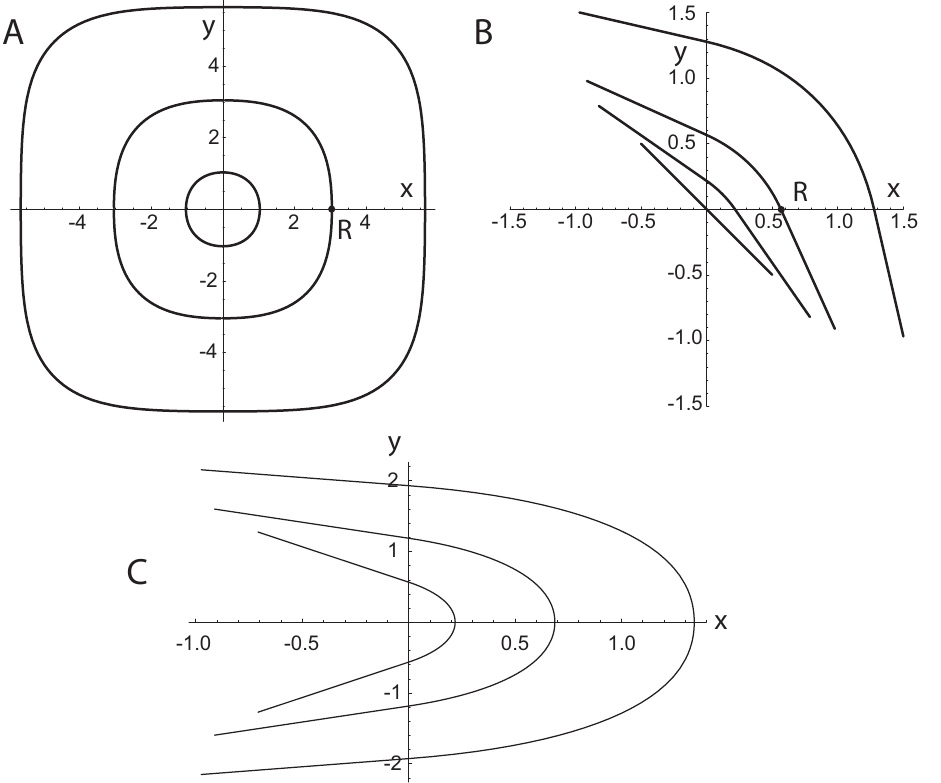
Figure 3. Optimal solutions for 2D exponential inputs: (A) closed ‘‘stretched circle’’ solutions are shown for l = 2 0.3, 2 0.9, 2 0.99, numbers correspond to the increasing size of the curved segment throughout this legend. (B) Extended solutions symmetric around y = x line are shown for l =0, 2 0.25, 2 0.5, 2 0.75. (C) Extended solutions symmetric around x =0 line are shown for l = 0, 2 0.5, 2 0.75 [this type turned out to be suboptimal, albeit by a small margin, compared to either A or B, cf. Figure